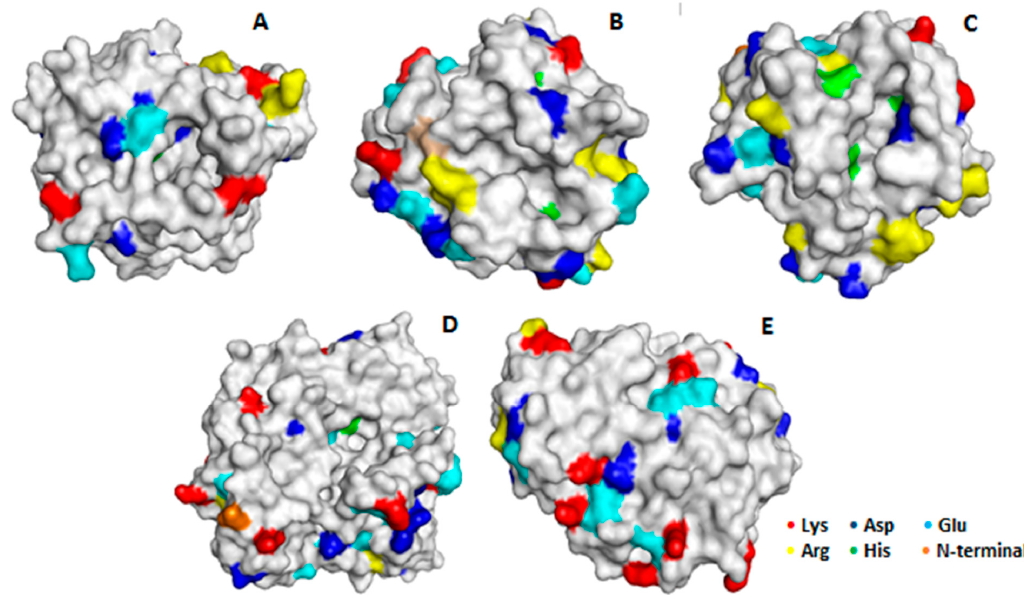
Figure 4. 3D surface structure models of lipases showing the face of the active center. ( A ) CALB (PDB Code 1TCA); ( B ) TLL (PDB code 1DT3; ( C ) RML (PDB code 4TGL); ( D ) CRL (PDB code 1CRL); ( E ) CALA (PDB code 3GUU). The 3D structures were obtained from the Protein Data bank (PDB) and displayed using Pymol version 0.99 (DeLano Scientific LLC, Philadelphia, PA, USA).